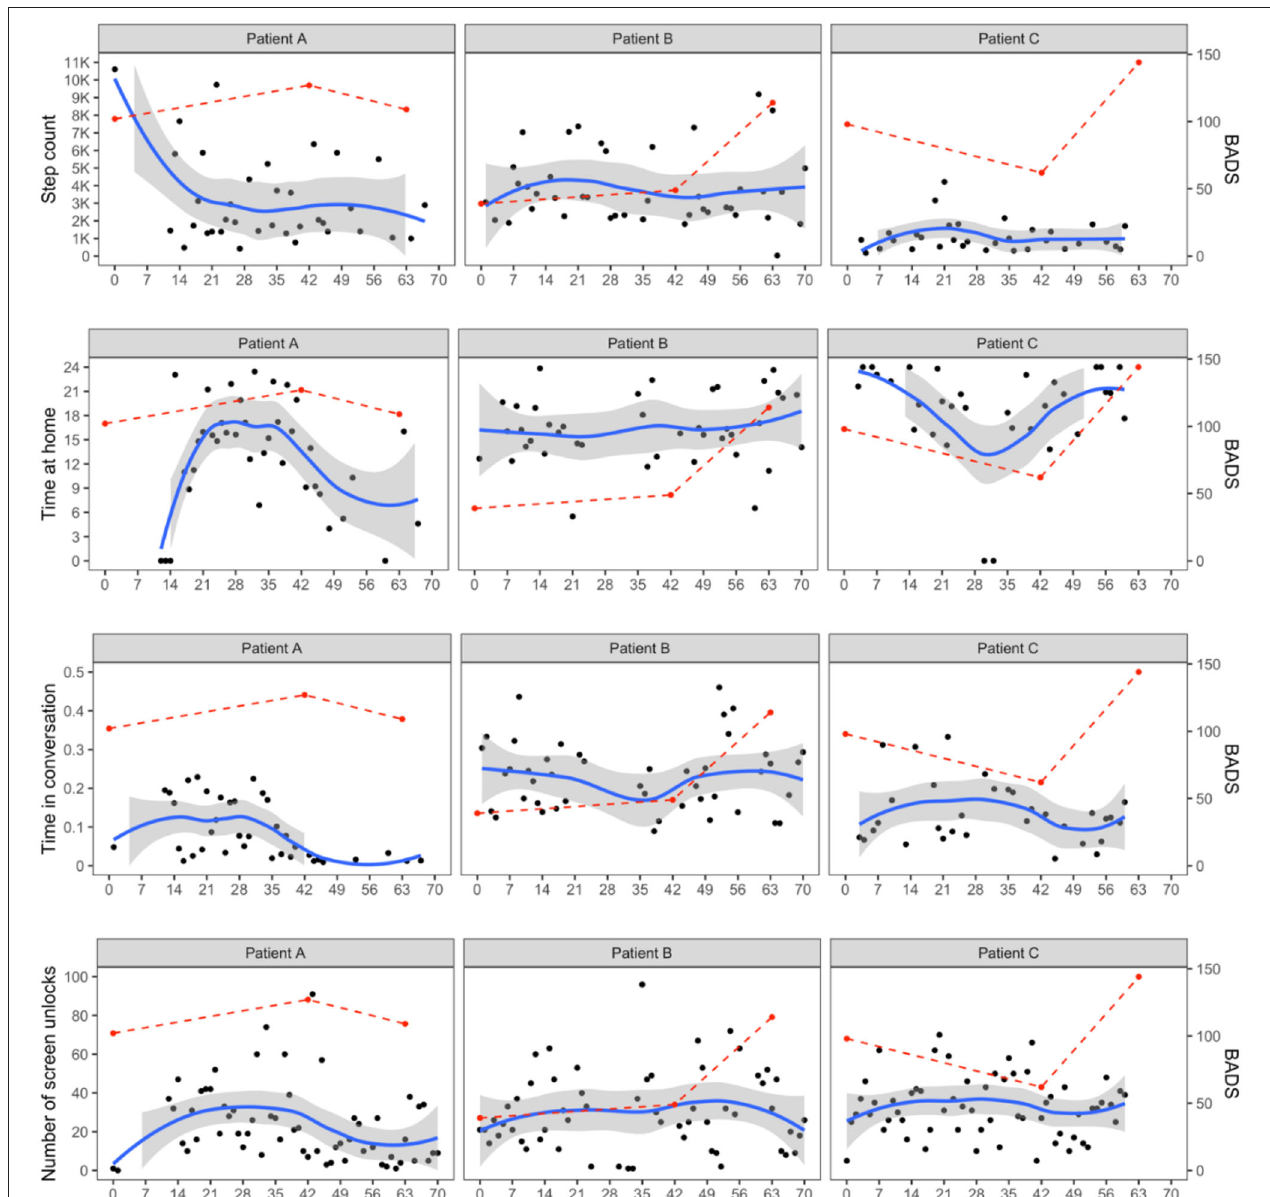
FIGURE 1 | Passive sensing data fluctuations over treatment. BADS, Behavioral Activation for Depression Scale. Columns represent patients and rows represent different smartphone data (step count, time spent at home, time in conversation, and the number of screen unlocks). For all panels, the x-axis shows time in days. Points in black represent daily recorded smartphone data and a blue line with a shaded band is a smooth local polynomial regression (LOESS) curve with its 95% confidence interval. Points and a dashed line in red show the fluctuations in BADS scores from baseline, weeks 6 to 9 (end of treatment).